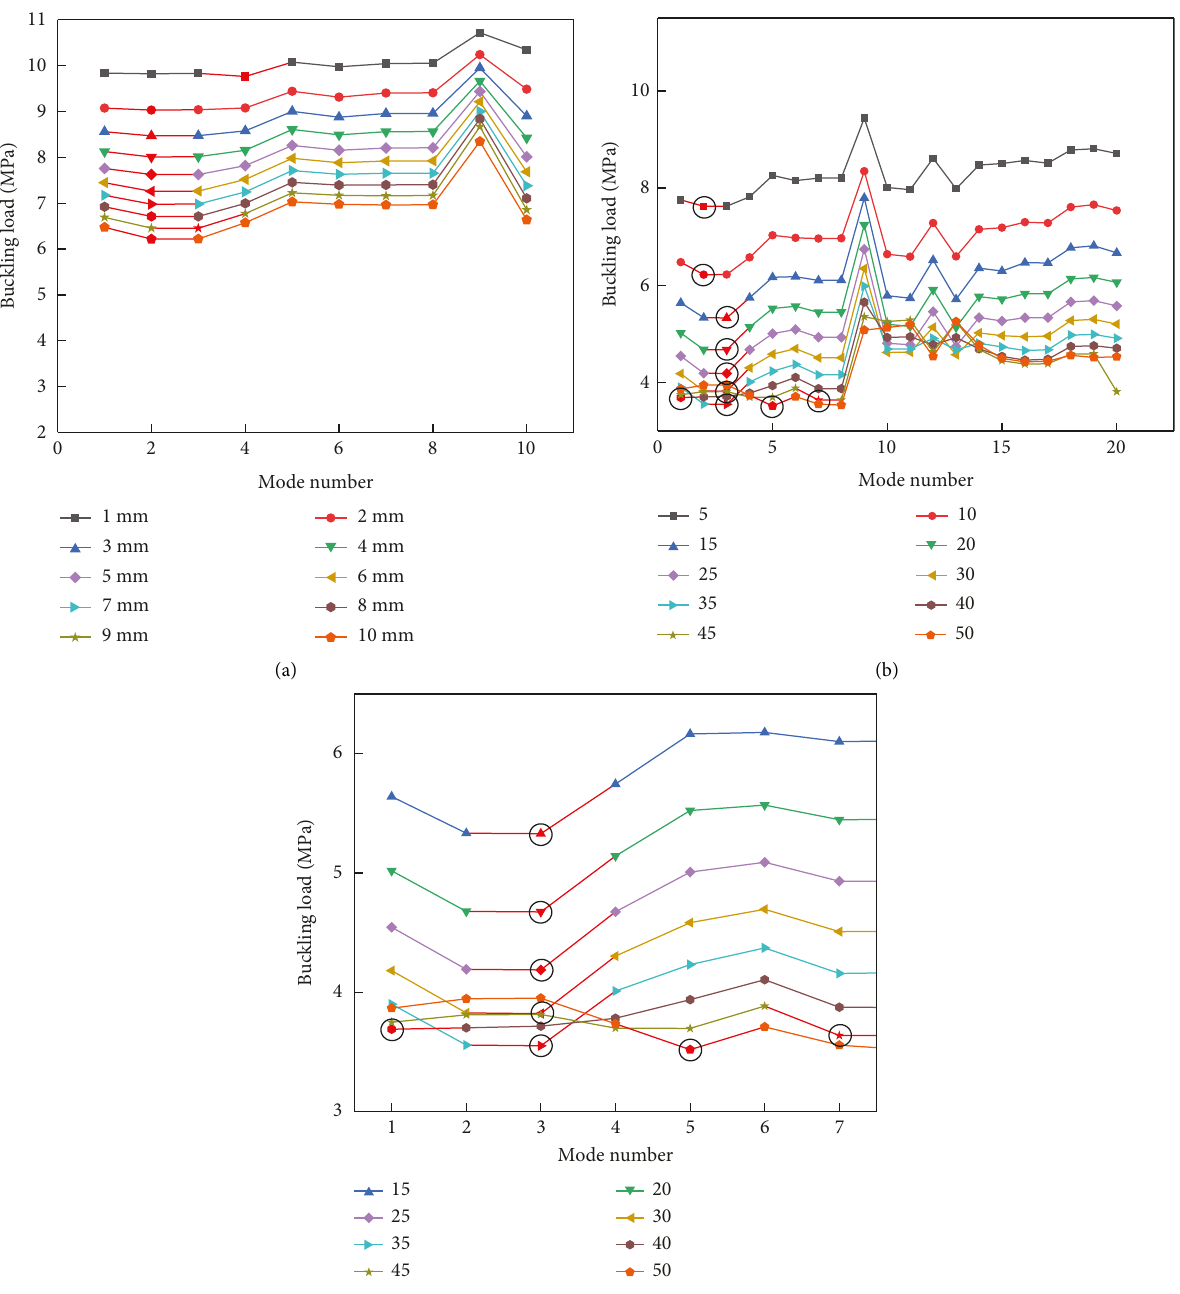
Figure 2: Modal load curve of the complete spherical shell using N-order modal method: (a) defect amplitude 1–10mm, (b) defect amplitude 5–50mm, and (c) defect amplitude 15–50mm (worst mode